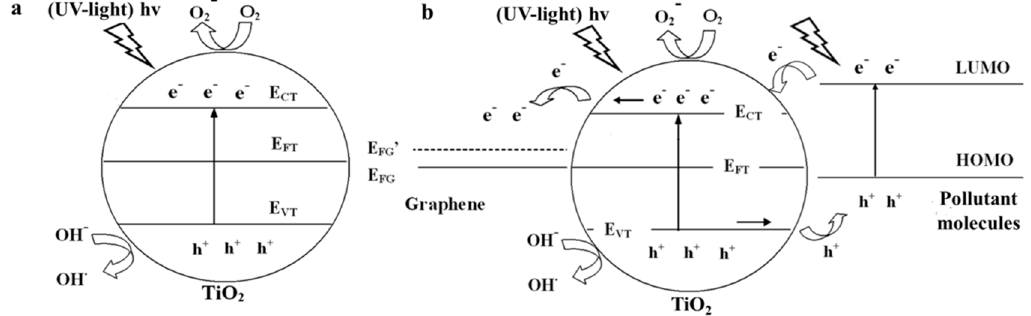
Figure 3. Photocatalytic mechanisms of ( a ) pure TiO 2 and the ( b ) graphene-TiO 2 composite under UV-light irradiation. Reproduced with permission from [14]. Copyright Elsevier, 2013.